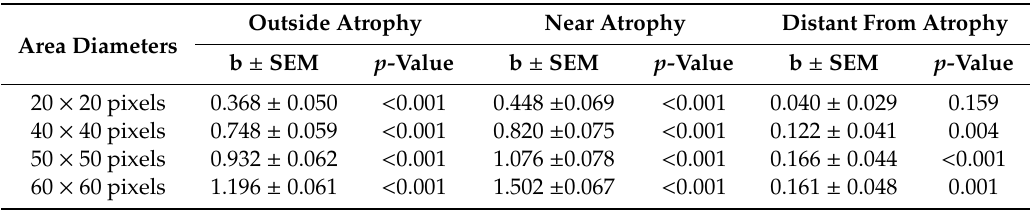
Figure 4. Scatter plots and linear regression lines showing the relationship between percent perfused choriocapillaris area and retinal sensitivity after stratification according to zone’s near atrophy and distant atrophy classification for each area considered. Panel ( A ) area 20 × 20 pixels, ( B ) area 40 × 40 pixels, ( C ) area 50 × 50 pixels, ( D ) area 60 × 60 pixels. Significant differences between linear regression coefficient were tested and all the p -values resulted <0.001. Table 3. Coefficient derived from a linear mixed model regression between percent perfused choriocapillaris area at different area diameters (as independent variables) and retinal sensitivity in the overall population and after stratification in the near atrophy and distant from atrophy zones’ subgroups.